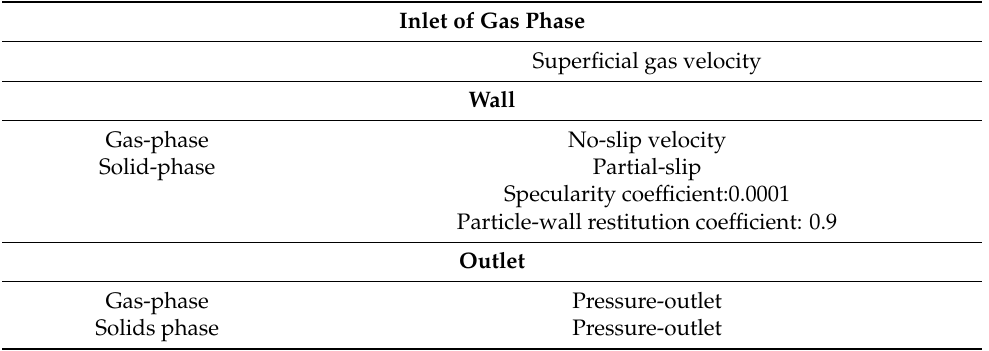
Table 4. Boundary conditions.